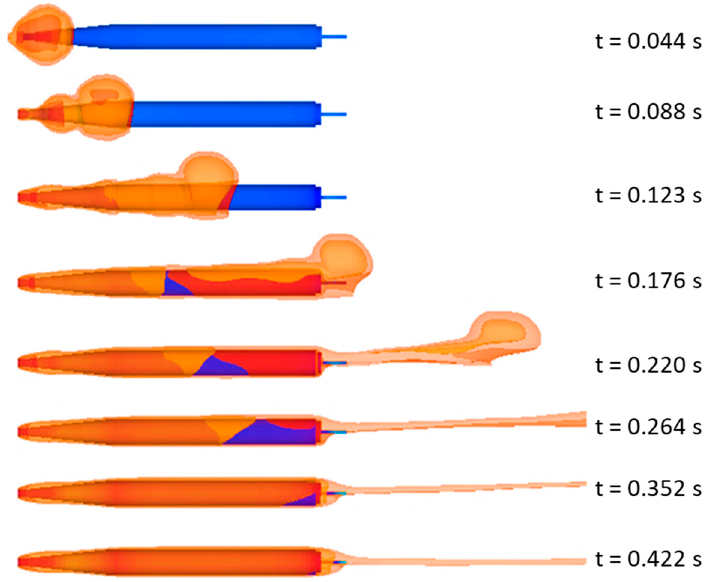
Figure 21. Prediction of ventilated super cavitation shape change over time.